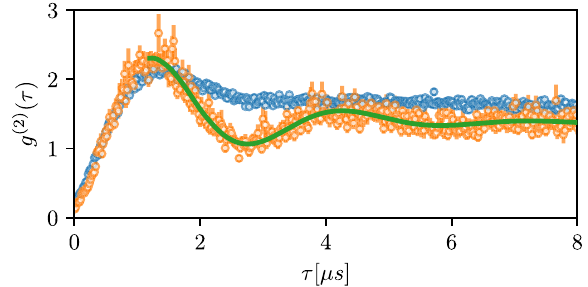
Fig. 5 Photon correlation function. Two-photon correlation function measured with two single-photon detectors in Hanbury Brown and Twiss con fi guration with a coincidence window of 20 ns. Shown are correlation functions for detunings Δ 12 = Δ 23 = 0 and driving strengths Ω 23 /2 π = 2.0 MHz (orange dots) and Ω 23 /2 π = 3.7 MHz (blue dots). On top of the orange dots is a sinusoidal fi t with exponentially decaying amplitude (green line). The error bars represent one standard deviation and are too small to be visible for some of the data points.